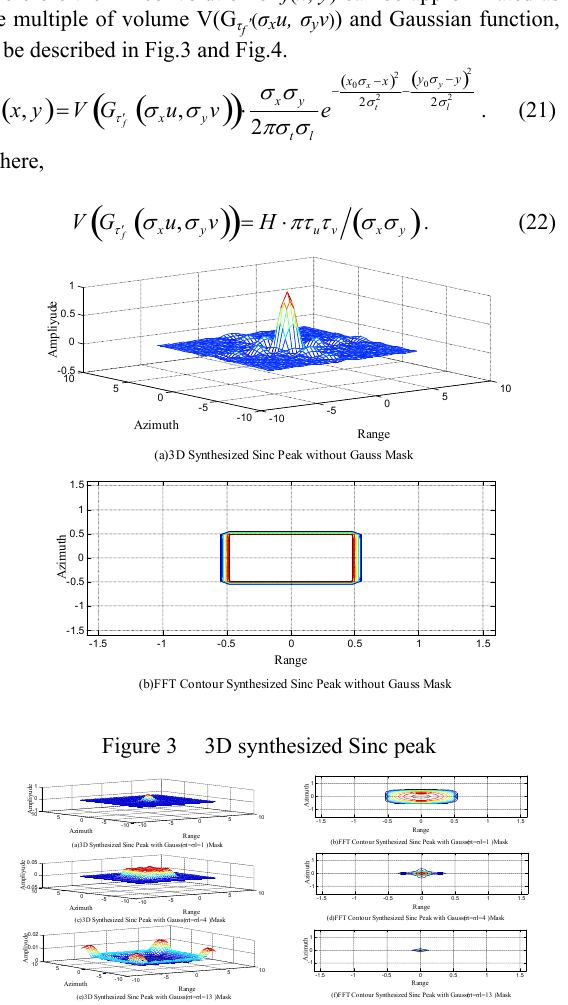
Figure 4 Compare Sinc Mask effect by different σ Guass function